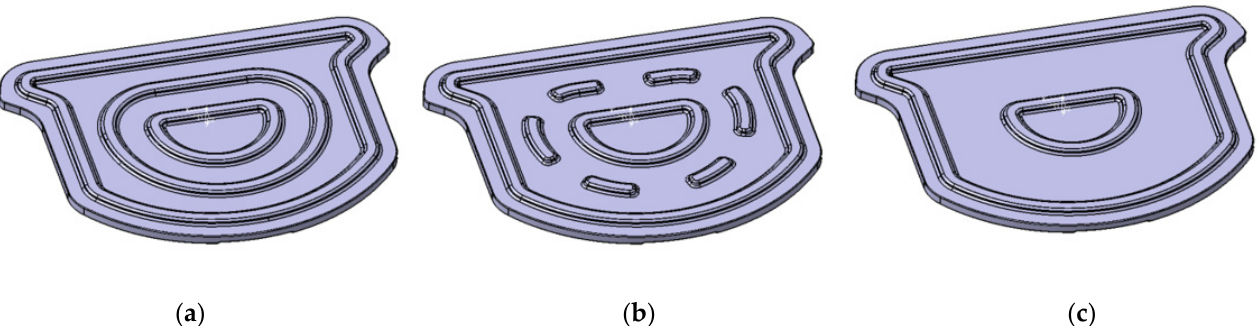
Figure 12. Improved designs of the stone grill plate bottom rib: ( a ) continuous rib design: modified burner tube but original stone grill plate, ( b ) discontinuous rib design: modified burner tube, with the continuous rib changed to a discontinuous one, ( c ) no continuous rib design: modified burner tube with no ribs.